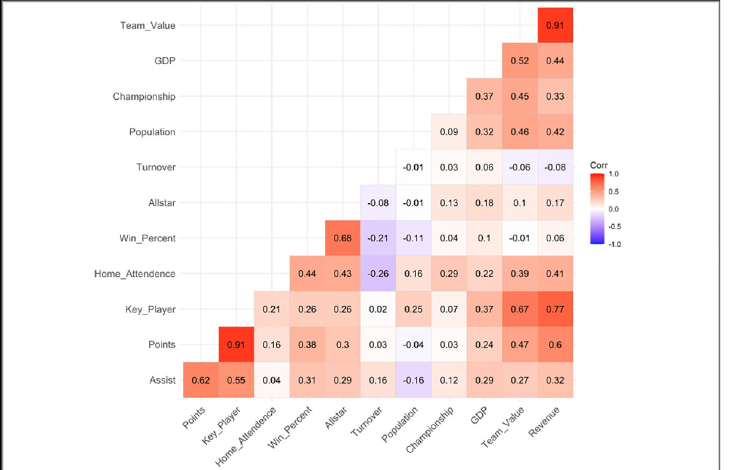
Fig 2. Correlation plot of the